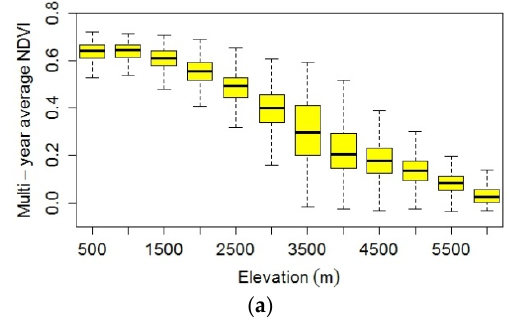
Figure 4. Cont. Figure 4. Cont.